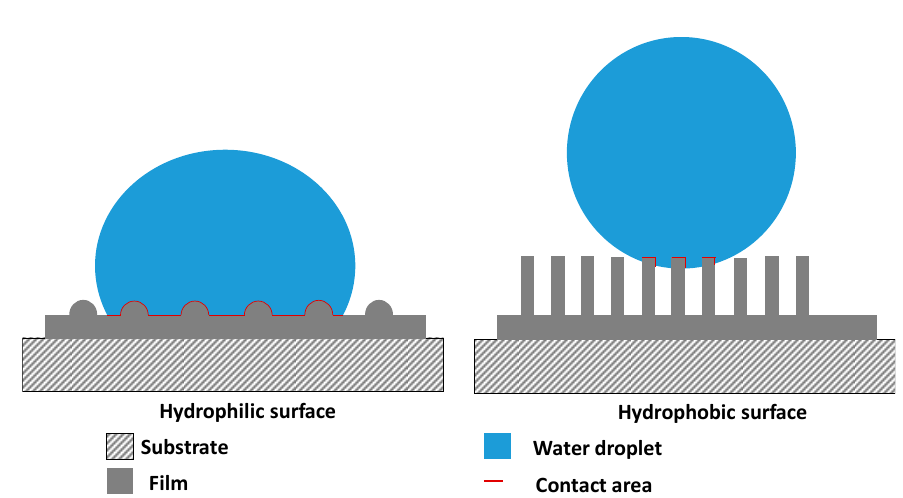
Figure 9. Film–water interaction for solid and nanostructured CN x :H films.